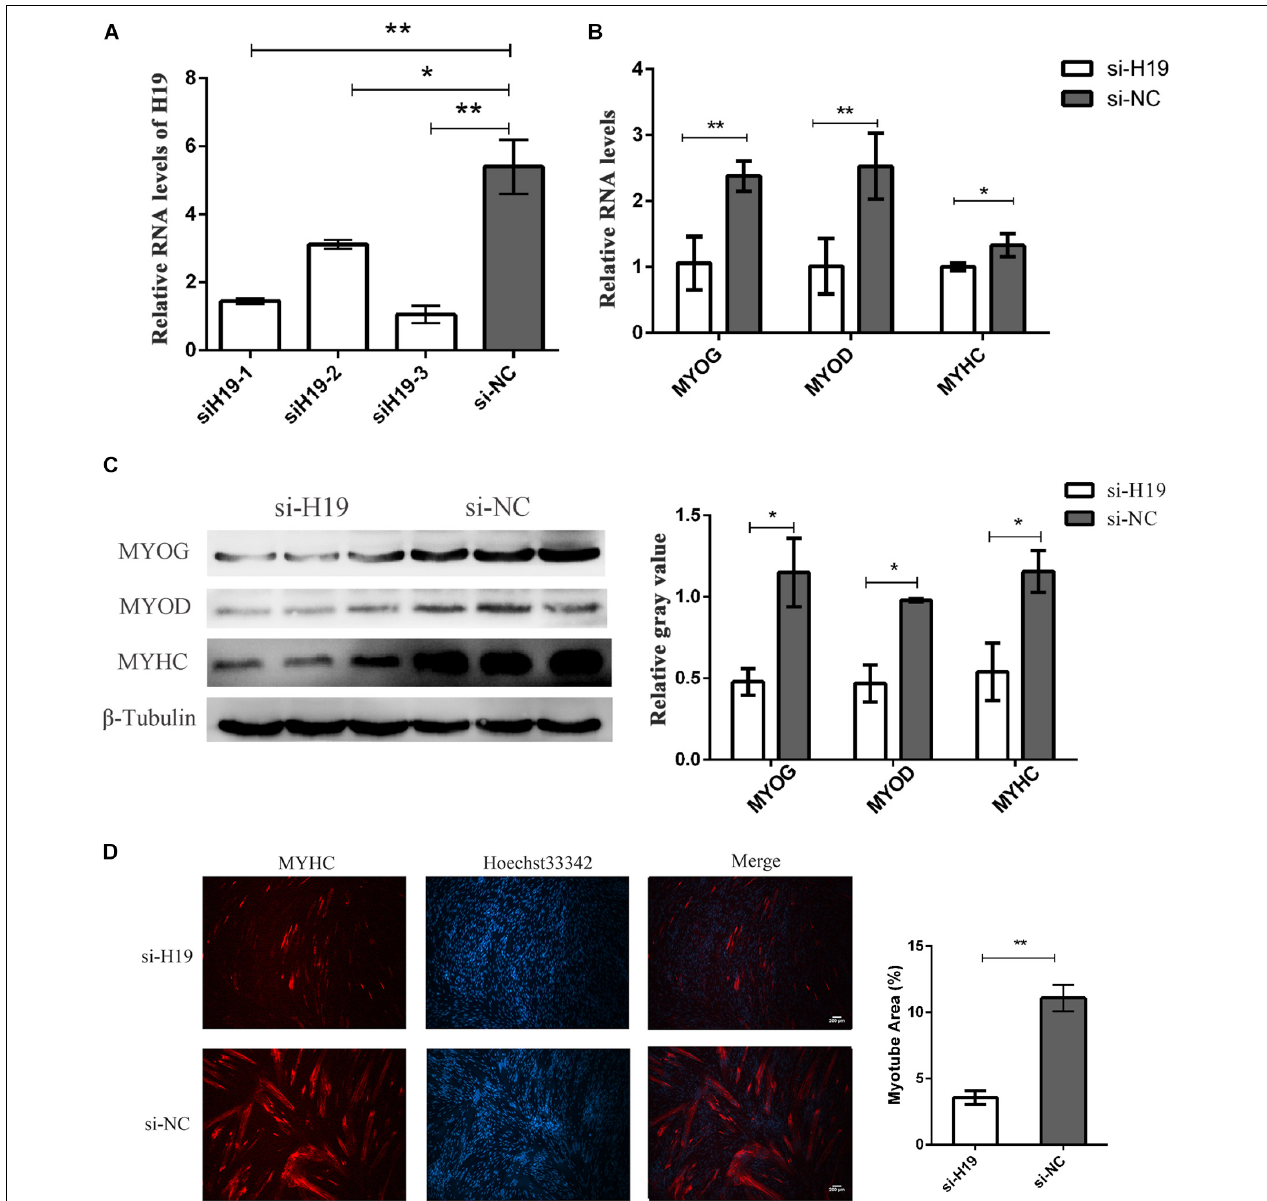
FIGURE 2 | The knockdown of H19. (A) Screening assay of siRNA of H19 showed the third siRNA that have the highest interference efficiency. (B) Knockdown of H19 decreased the mRNA levels of MYOG, MYOD, and MYHC. (C) Knockdown of H19 decreased the levels of MYOG, MYOD, and MYHC protein. The gray level of WB was calculated by Image J software. Each experiment had three biological replicates. (D) Knockdown of H19 inhibited the differentiation of PSCs. PSCs transfected with either H19 siRNA or NC siRNAs were induced to differentiate. After differentiation for 24 h, cells were fixed and stained for MYHC, the marker of muscle differentiation. The fluorescence intensity and myotube area were calculated by Image J software. Each experiment had three biological replicates. Mean values ± SEM, n = 3. * p < 0.05, ** p <